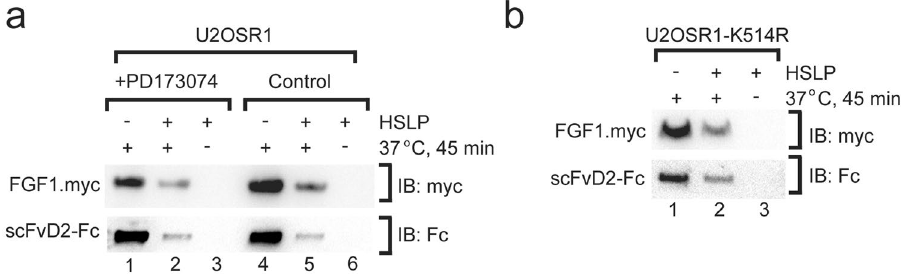
Figure 4. The activation of FGFR1 is not required for the internalization of scFvD2-Fc antibody. ( a ) Internalization of scFvD2-Fc and FGF1 is not affected by the presence of potent FGFR kinase inhibitor PD173074. U2OSR1 cells were preincubated with either DMSO (control) or PD173074 (100 nM) for 15 min and the internalization of FGF1 and scFvD2-Fc was analyzed as in Fig. 3a. ( b ) FGF1 and scFvD2-Fc are taken up by